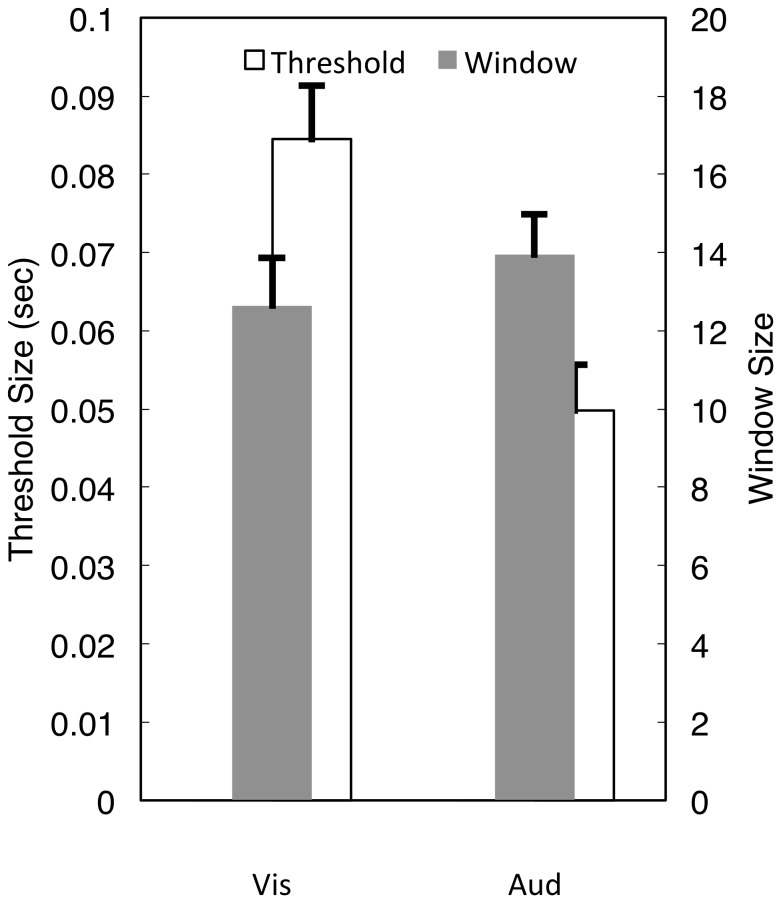
Model fits of experimental data.Individual fits indicated that the window size of the memory prior did not differ between participants performing on the auditory or visual versions of the task. However, uncertainty threshold values did significantly differ, with higher thresholds for visual participants (p<0.05). Error bars represent s.e. of the mean.